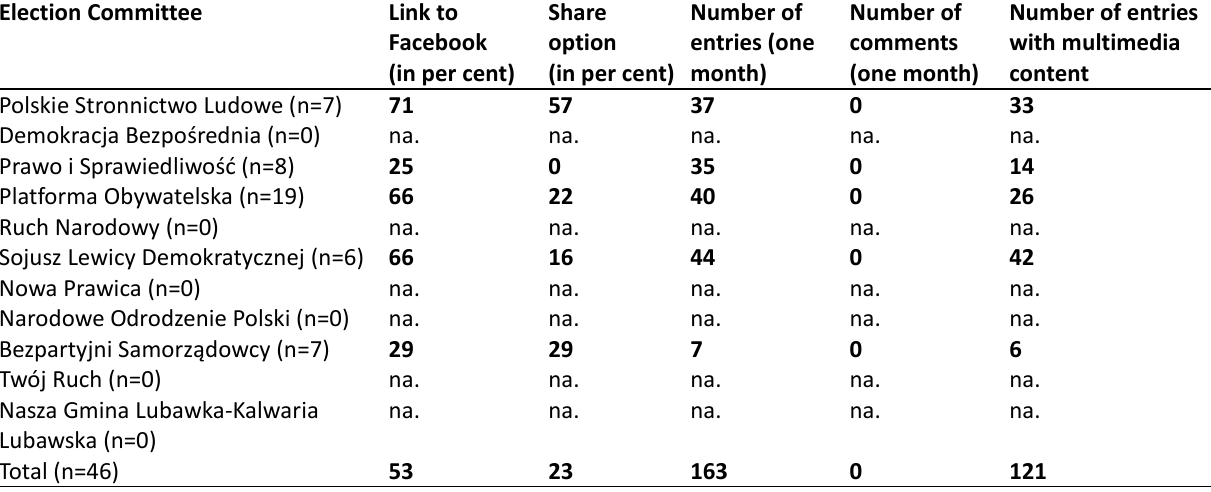
Table 3. The structure and features of